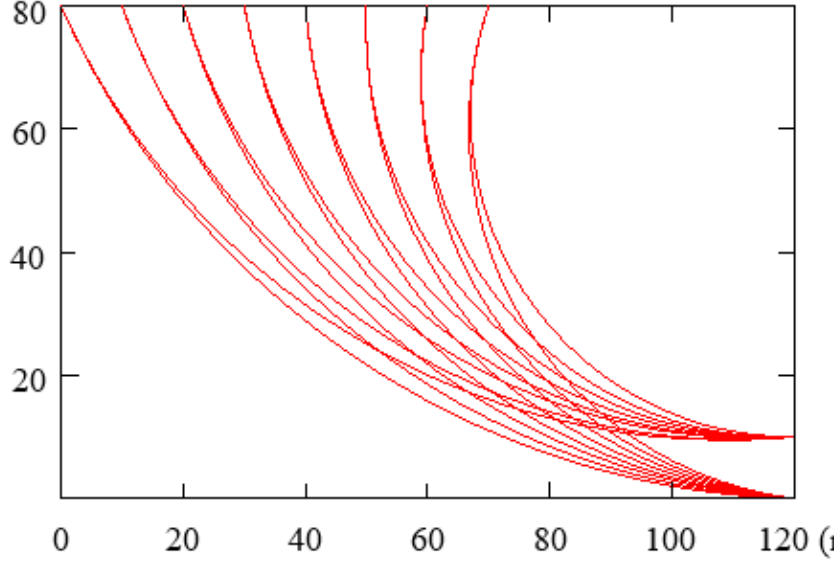
Figure 11. A total of 16 potential slip surfaces for the designated shear entrance and exit.